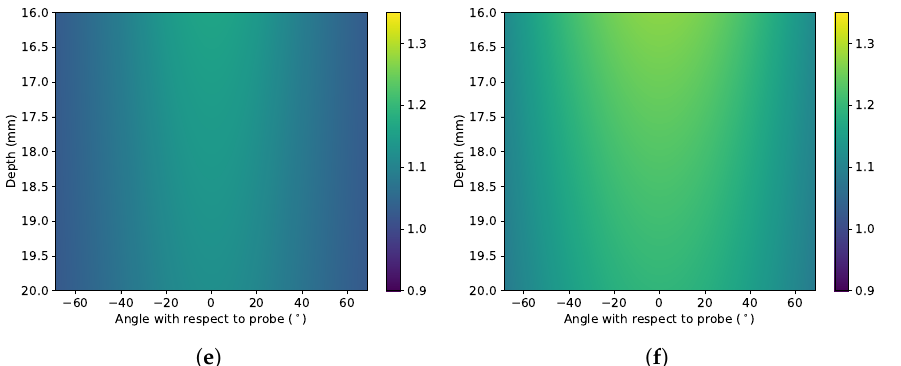
Figure 2. FEBio simulation of λ 1,2,3 values at 8 and 14 mm indentations. ( a ) λ 1 at 8 mm. ( b ) λ 1 at 14 mm. ( c ) λ 2 at 8 mm. ( d ) λ 2 at 14 mm. ( e ) λ 3 at 8 mm. ( f ) λ 3 at 14 mm.